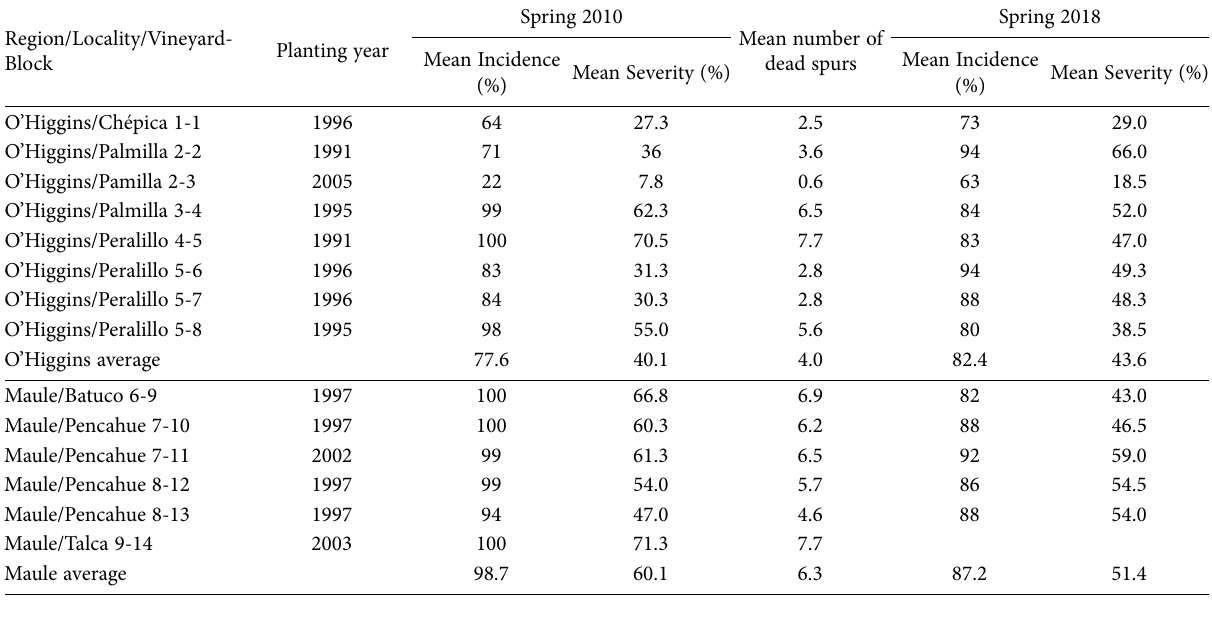
Table 3. Incidence and severity of Botryosphaeria dieback in Chilean vineyards of ‘Cabernet Sauvignon’ in O’Higgins and Maule Regions.